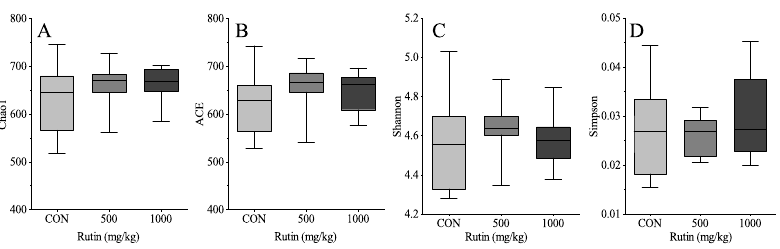
Figure 1. Alpha diversity of caecal microflora in aged laying hens. Chao1 ( A ), ACE ( B ), Shannon ( C ), and Simpson ( D ). Data are expressed as the mean ± SEM. Different lower-case letters indicate a significant difference among different groups ( P < 0.05).